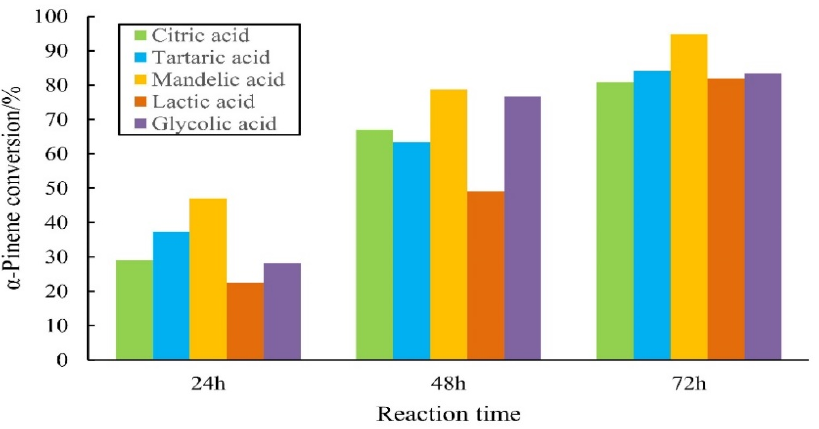
Figure 1. Comparison of conversion of alpha-pinene with AHA as the catalyst. Note: the mass ratio of alpha-pinene, water, and AHA was 1:1:1, at 70 ◦